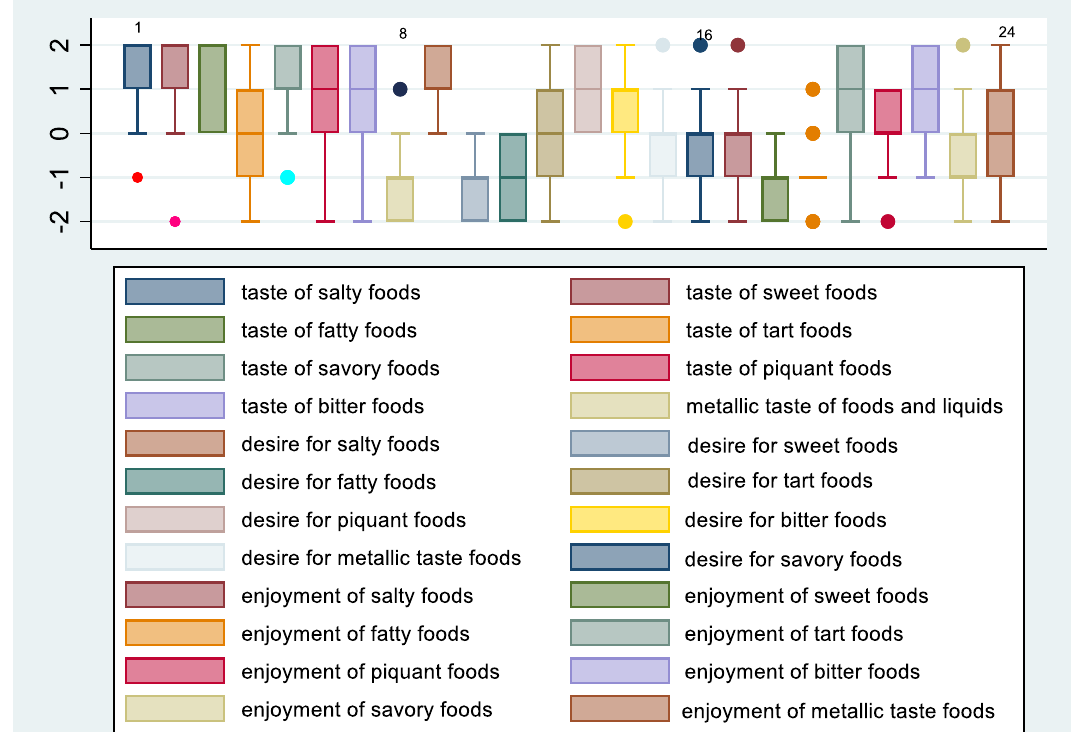
Figure 3. Change in taste, desire, and enjoyment 12 months after SG in females.